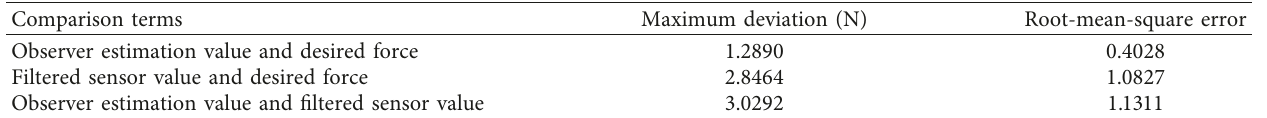
Table 6: Comparison of Z -direction force control errors in Figure